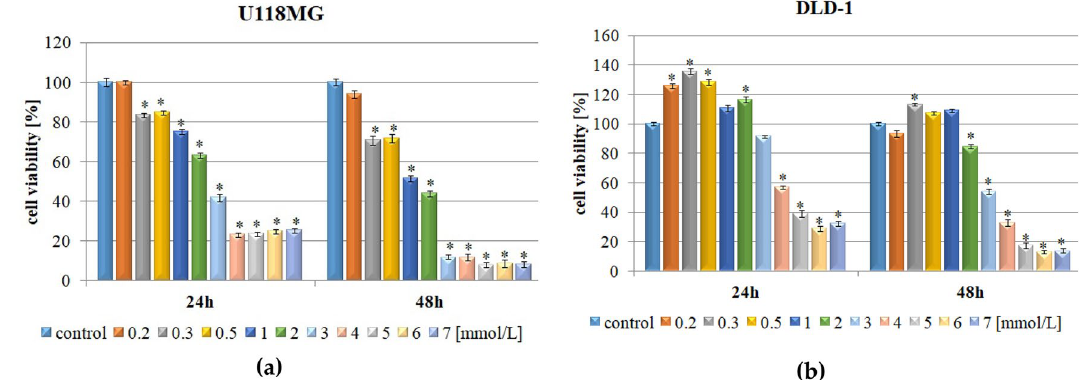
Figure 1. Cytotoxic effect of different concentrations of caffeic acid against U118MG ( a ) and DLD-1 ( b ) cells. Values are expressed as means ± SD from three individual experiments run in triplicates. *Indicates statistical significance ( p ≤ 0.05) in comparison to untreated control cells (0